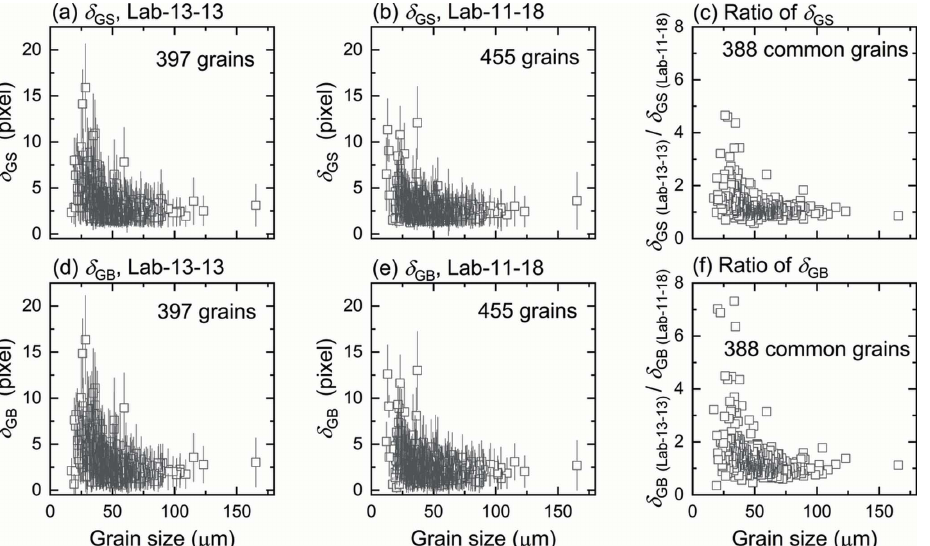
Figure 6 GS deviation (cid:2) GS for ( a ) 397 grains in Lab-13-13 and ( b ) 455 grains in Lab-11-18, and GB deviation (cid:2) GB for ( d ) Lab-13-13 and ( e ) Lab-11-18 as a function of grain size. ( c ) and ( f ) show the ratios of (cid:2) GS and (cid:2) GB for data in Lab-13-13 divided by that in Lab-11-18 for the 388 common one-to-one indexed grains. The size of the scatter bars in ( c ) and ( f ) are on average (cid:4) 1.7 but they are omitted in the plots for